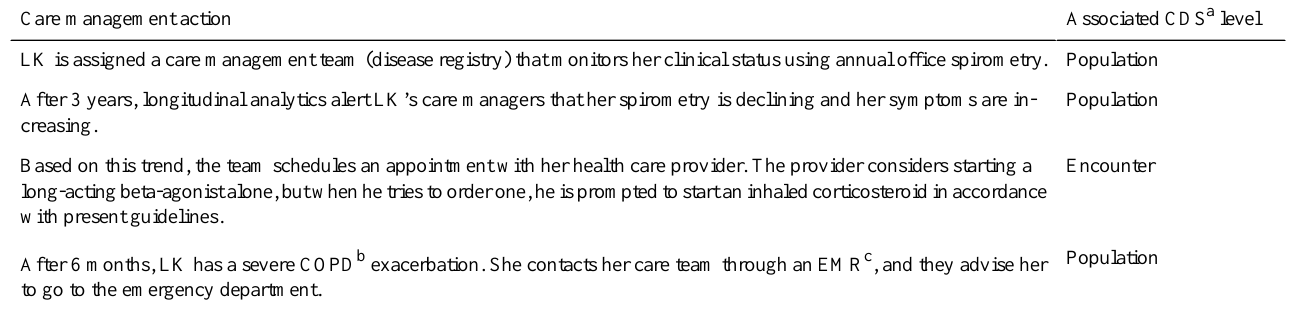
Associated CDS a levelCare management